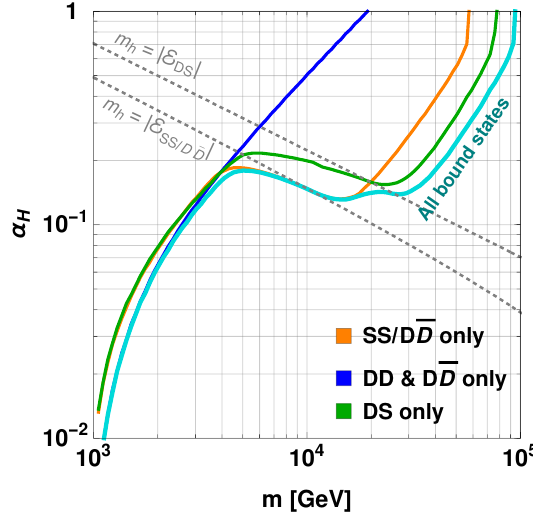
Figure 7 . α H vs. m such that the observed DM density is attained via thermal decoupling, considering the contributions of the various bound states